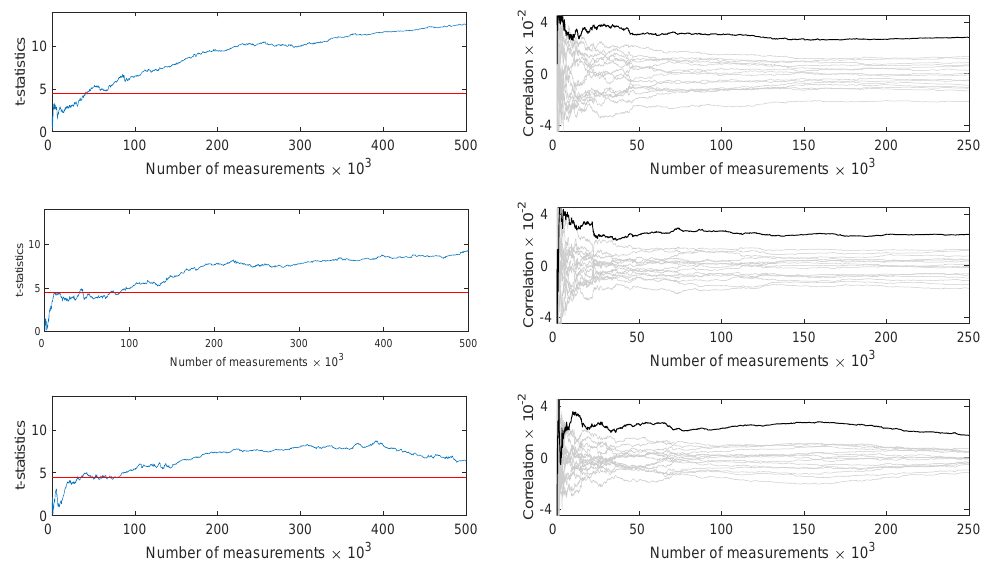
Figure 10: Non-specific t -test and CPA results on static power measurements from the first sample of the 65 nm ASIC after 0, 4 and 8 weeks of aging (top to bottom). The CPA targets a key nibble in the first round using the HW of the S-box